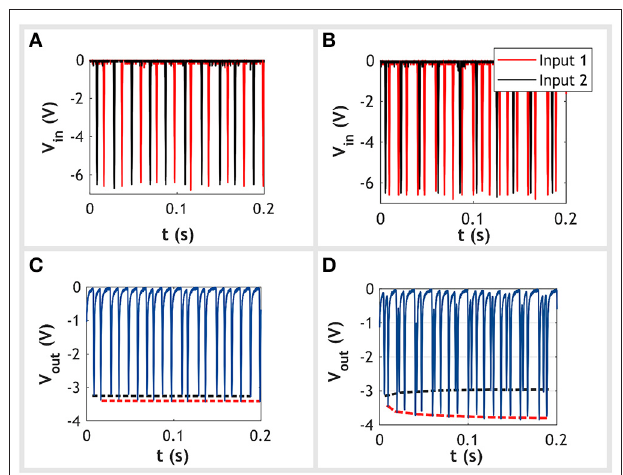
FIGURE 2 | Experimental data demonstrating the circuit’s ability to detect differences in frequency between two input spike trains. Two scenarios are presented: the first with no difference in input frequency and the second with a difference of 50 Hz. Spikes are Gaussian shaped with a full width at half maximum (FWHM) of 1.3 ms. Each Gaussian pulse has been cropped to a width 2 ms. (A,C) These show the input and output signals, respectively, for the case of no difference in input frequency. Both input 1 (red trace) and input 2 (black trace) are set to 50 Hz. In the plot beneath we see the amplitude of spikes at the output remain approximately constant for both inputs. For clarity we have included an envelope tracking the output spikes caused by input 1 (dotted red trace) and input 2 (dotted black trace). (B,D) Shows the input and output signals, respectively, for the case with a 50 Hz difference in input frequency between the two inputs. Input 1 is set to 100 Hz while input 2 remains at 50 Hz. For clarity, we have again overlaid two envelopes tracking the output spikes caused by input 1 and input 2. This time, we observe at the output that spikes caused by input 1 increase in amplitude over time, whereas those from input 2 remain